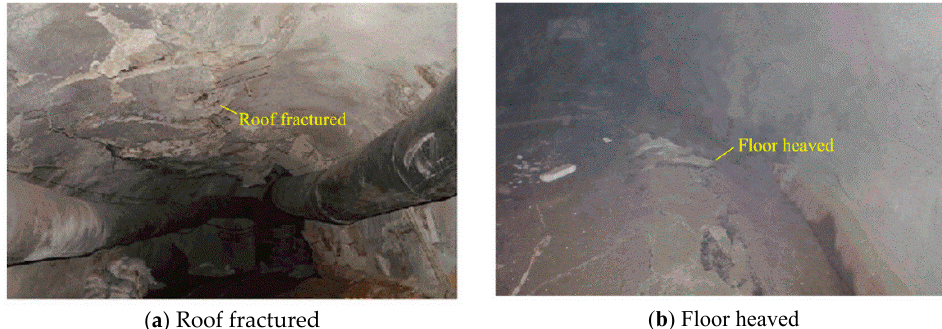
Figure 4. Roadway failure characteristics under the initial supporting design.